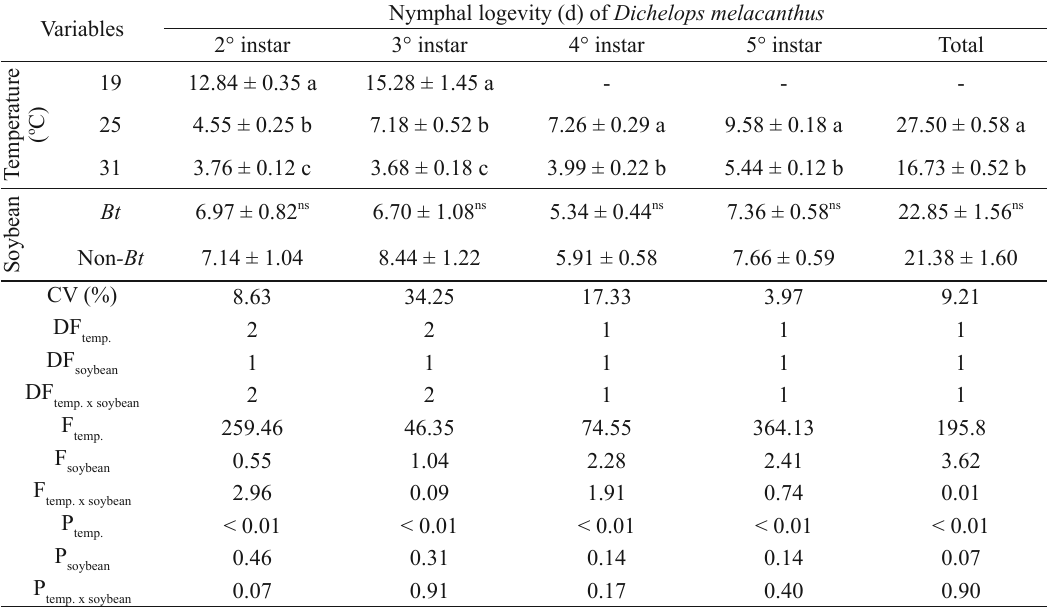
In fl uence of temperature on the nymphal longevity of Dichelops melacanthus developed on Bt and non Bt isogenic soybean pods.